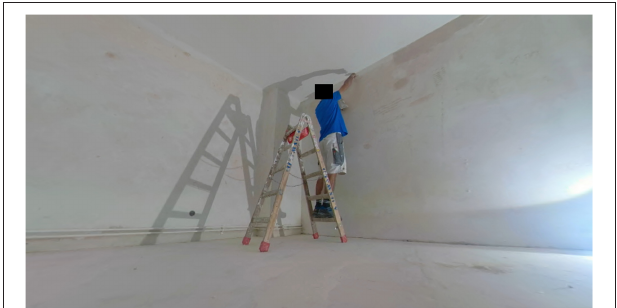
FIGURE 2 | Plastering worker standing on a ladder in a potentially hazardous